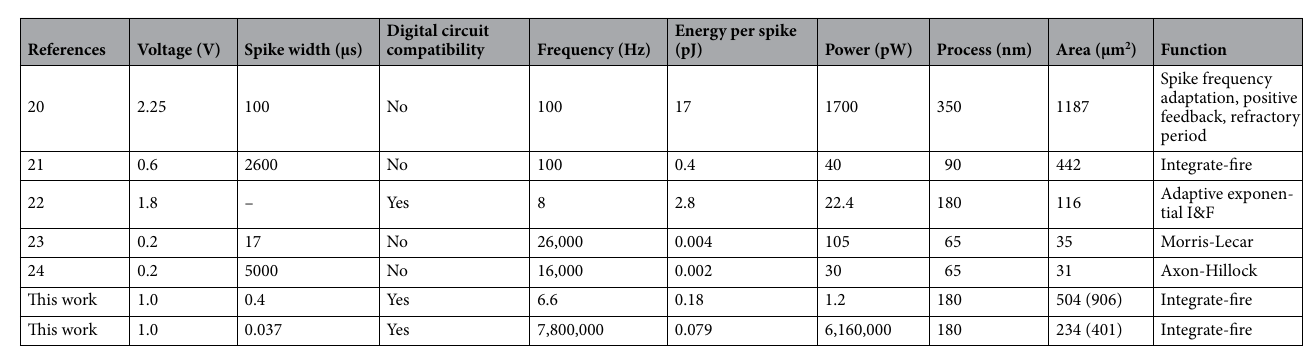
Table 1. Benchmark of neuron circuits. The characteristics of the spiking neuron circuit in this work are compared with the state-of-the-art neuron circuits that were experimentally fabricated in the past literature. The area only includes the membrane capacitor and the subsequent circuits while the values in the brackets include the current generation MOSFETs at the input of the spiking neuron